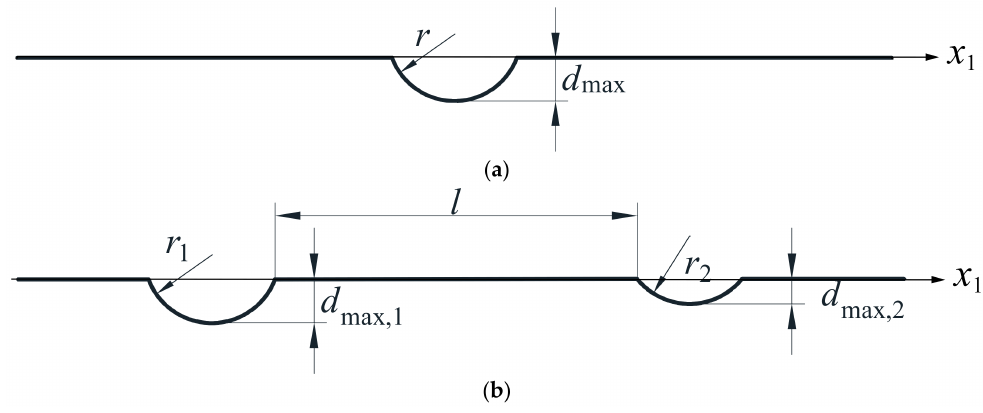
Figure 4. Numerical examples: ( a ) a half-space with an arc-shaped canyon flaw; ( b ) a half-space with double canyons.